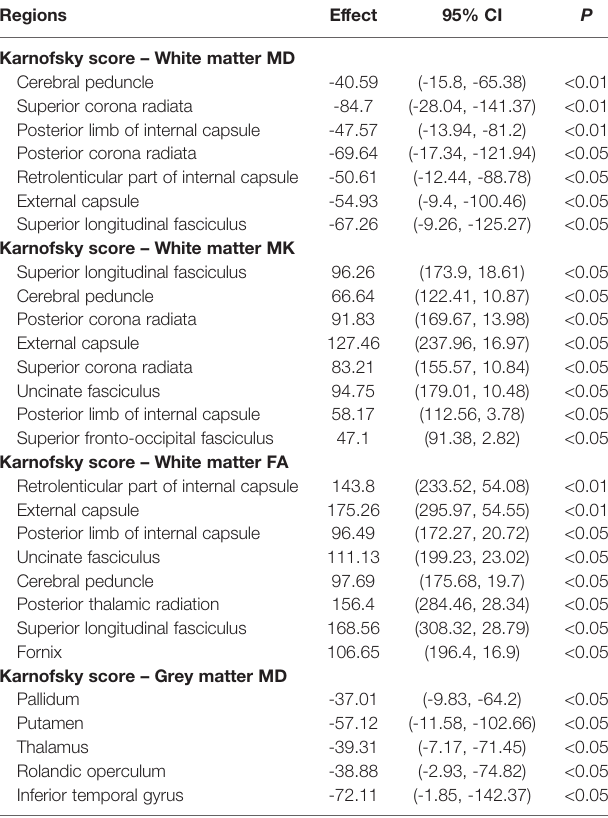
TABLE 3B | Multiple regression analysis of the relationships between Karnofsky score and diffusion metrics of all brain regions in the AAL